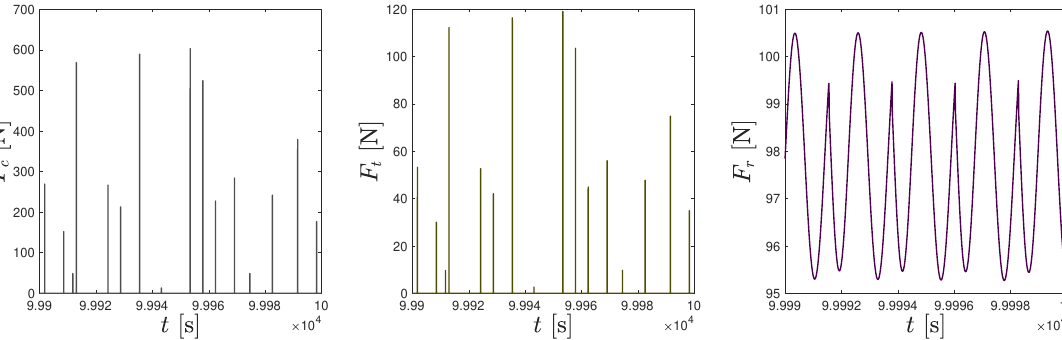
Figure 9. Investigated system’s (1) forces F c , F t , and F r for e T = 0.02 m, ω = 2.8 rad s − 1 , and z a = 0.0056